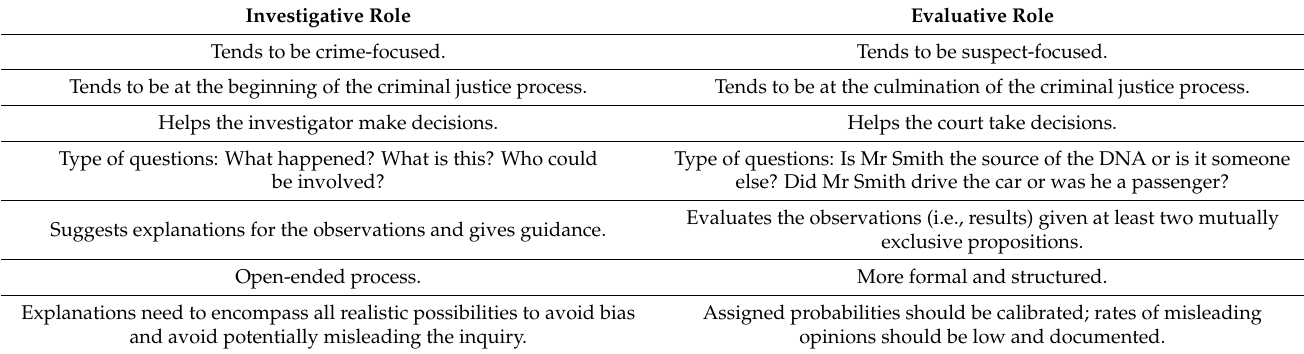
Table 1. Differences between investigative and evaluative